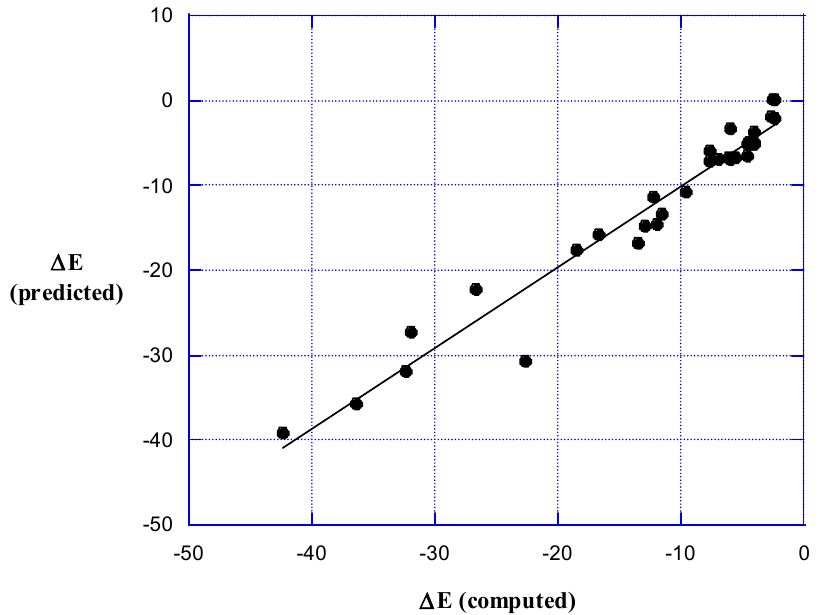
Figure 4. ∆ E predicted with Equation (5) plotted against the computed ∆ E, in kcal / mol, for the π -hole Figure 4. Δ E predicted with Equation (5) plotted against the computed Δ E, in kcal/mol, for the π -hole interactions in Table 2. R 2 = interactions in Table 2. R 2 = 0.952.